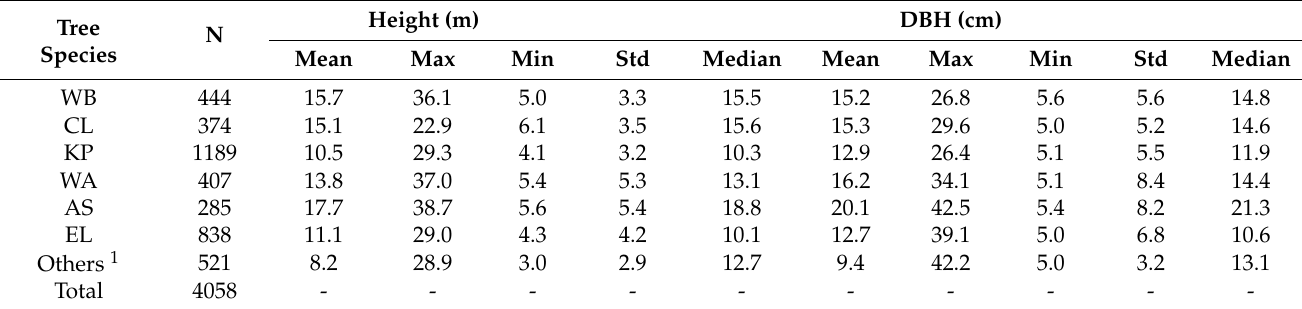
Table 1. The descriptive statistics for main tree species of the 12 sample